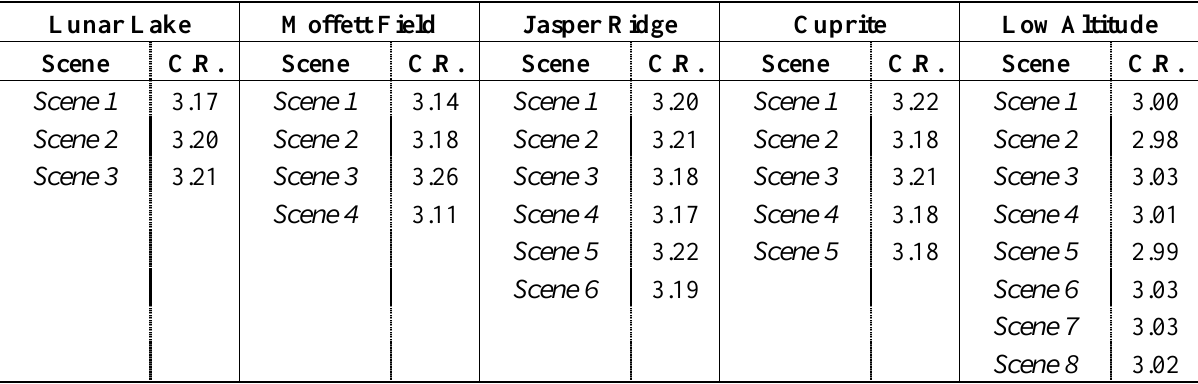
Table 1. Results (C.R. achieved for each scene of the hyperspectral imagery without band